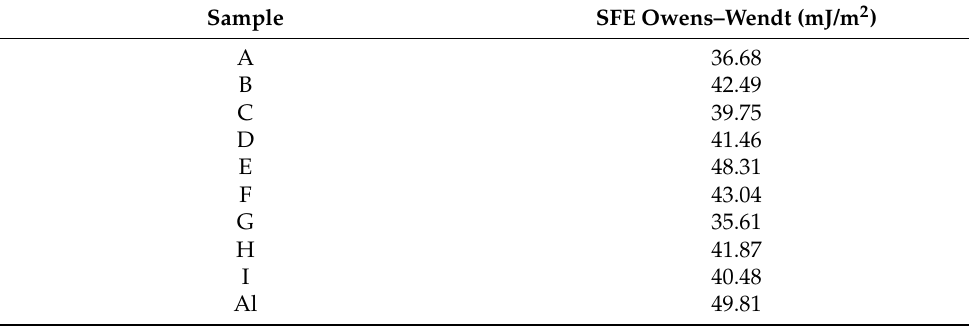
Table 8. Free surface energy of Al 2 O 3 layers for glycerin and diiodomethane.